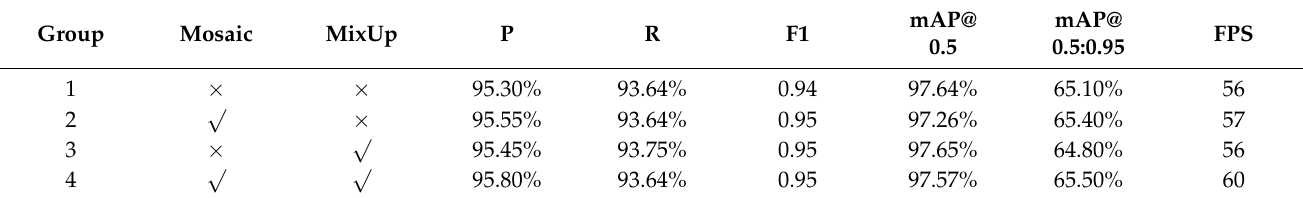
Table 5. Ablation